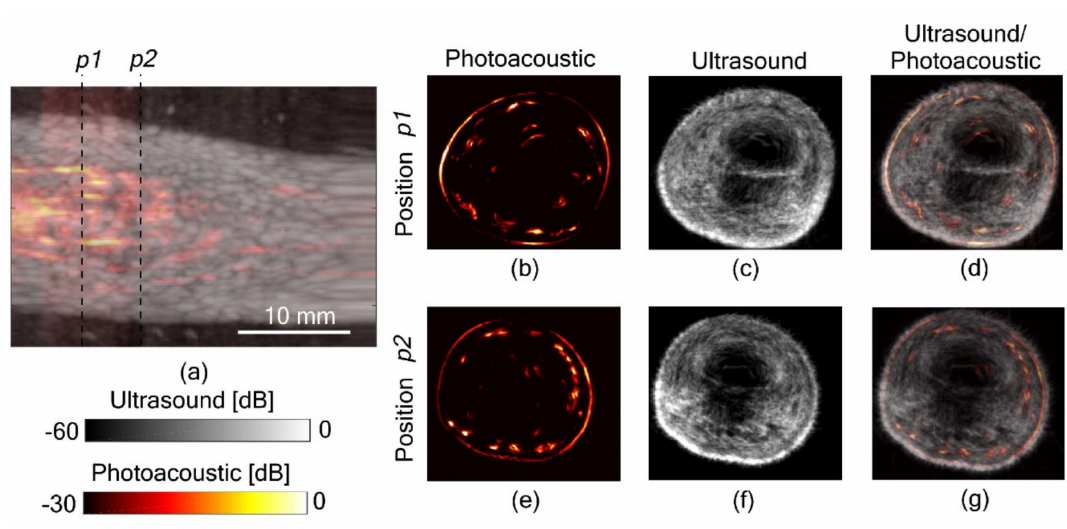
Figure 13. In-vivo finger joint tomographic imaging using multi-angle spatial compounding. ( a ) Overlaid LED-based PA and US MIP image showing finger joint from a linear scan. ( b ) PA, ( c ) US and ( d ) combined tomographic images of the finger joint (p1). ( e ) PA, ( f ) US and ( g ) combined tomographic images 5 mm in front of the joint (p2), respectively. Reprinted from